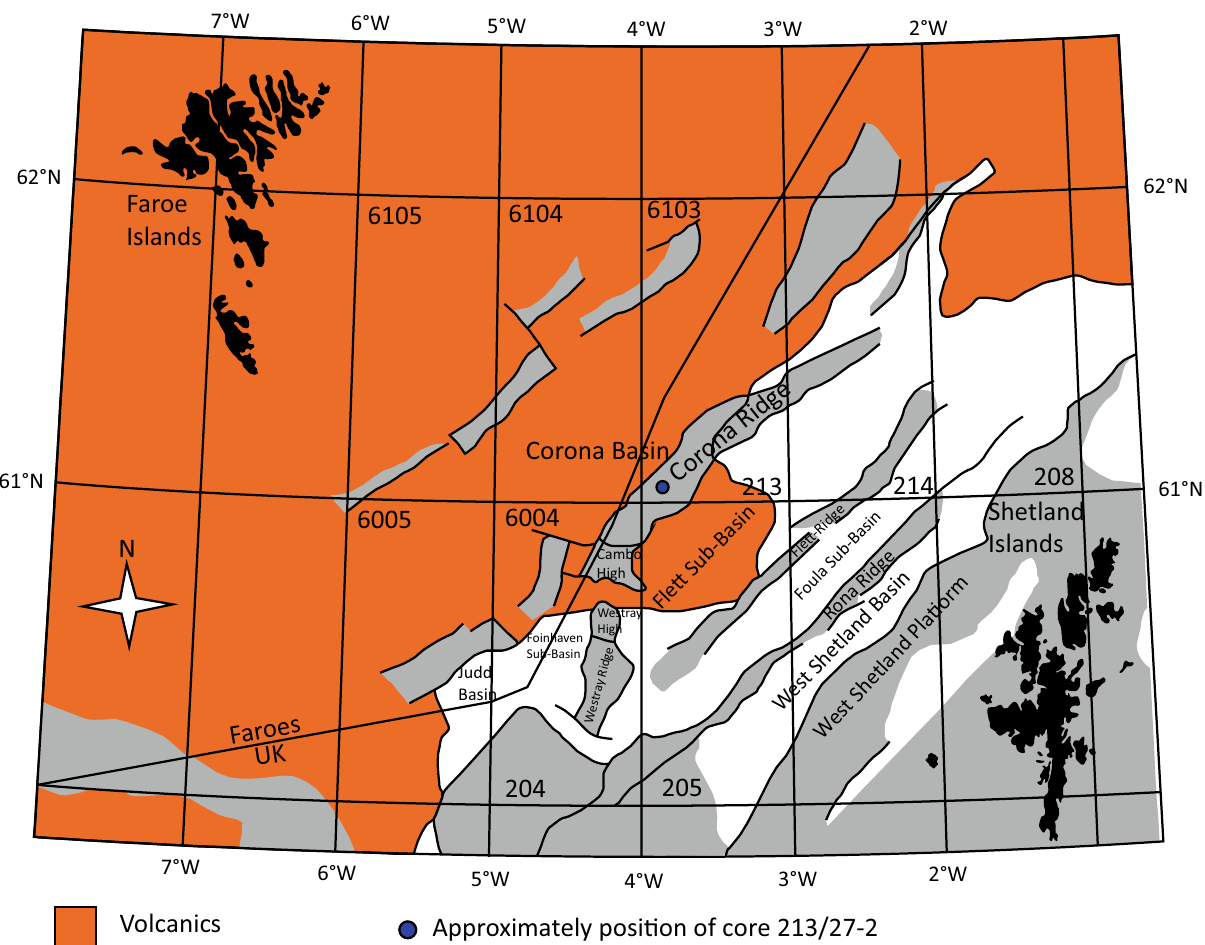
Figure 1. Overview of the Faroe-Shetland Basin (FSB) with approximately position of core 213/27-2. Modified from 13